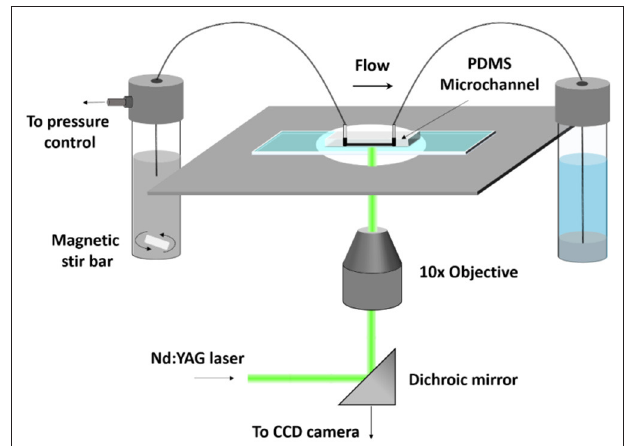
FIGURE 1 | Schematic of the µ PIV system used in this